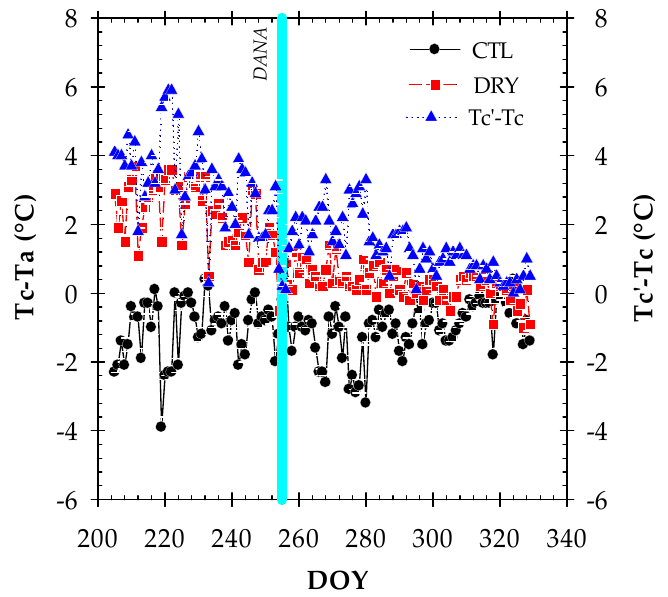
Figure 4. The canopy-to-air temperature difference (Tc − Ta) values in the CTL (full-irrigated) and Figure (cid:561) 4. (cid:561) The (cid:561) canopy (cid:442) to (cid:442) air (cid:561) temperature (cid:561) difference (cid:561) (Tc (cid:442) Ta) (cid:561) values (cid:561) in (cid:561) the (cid:561) CTL (cid:561) (full (cid:442) irrigated) (cid:561) and (cid:561) DRY (cid:561) (non (cid:442) irrigated) (cid:561) treatments. (cid:561) The (cid:561) canopy (cid:561) temperature (cid:561) difference (cid:561) between (cid:561) DRY (cid:561) (Tc’) (cid:561) to (cid:561) CTL (cid:561) (Tc) (cid:561) DRY (non-irrigated) treatments. The canopy temperature difference between DRY (Tc’) to CTL (Tc) treatments. (cid:561) Values (cid:561) are (cid:561) daily (cid:561) means (cid:561) ± (cid:561) SE (cid:561) from (cid:561) three (cid:561) infrared (cid:561) radiometer (cid:561) sensors. (cid:561) The (cid:561) solid (cid:561) vertical (cid:561) treatments. Values are daily means ± SE from three infrared radiometer sensors. The solid vertical cyan (cid:561) line (cid:561) indicates (cid:561) the (cid:561) DANA (cid:561) event. (cid:561) cyan line indicates the DANA Table (cid:561) 1 (cid:561) includes (cid:561) the (cid:561) linear (cid:561) relationships (cid:561) between (cid:561) Tc (cid:442) Ta (cid:561) vs. (cid:561) VPD, (cid:561) and (cid:561) Tc’ (cid:442) Tc (cid:561) vs. (cid:561) VPD (cid:561) at (cid:561) dif (cid:556)